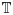
(a) An intuitive example to demonstrate matrix  T. (b) the schematic plot of computing the probability of foreground and background. Red represents seeds of the foreground and the centroid of the attraction region.